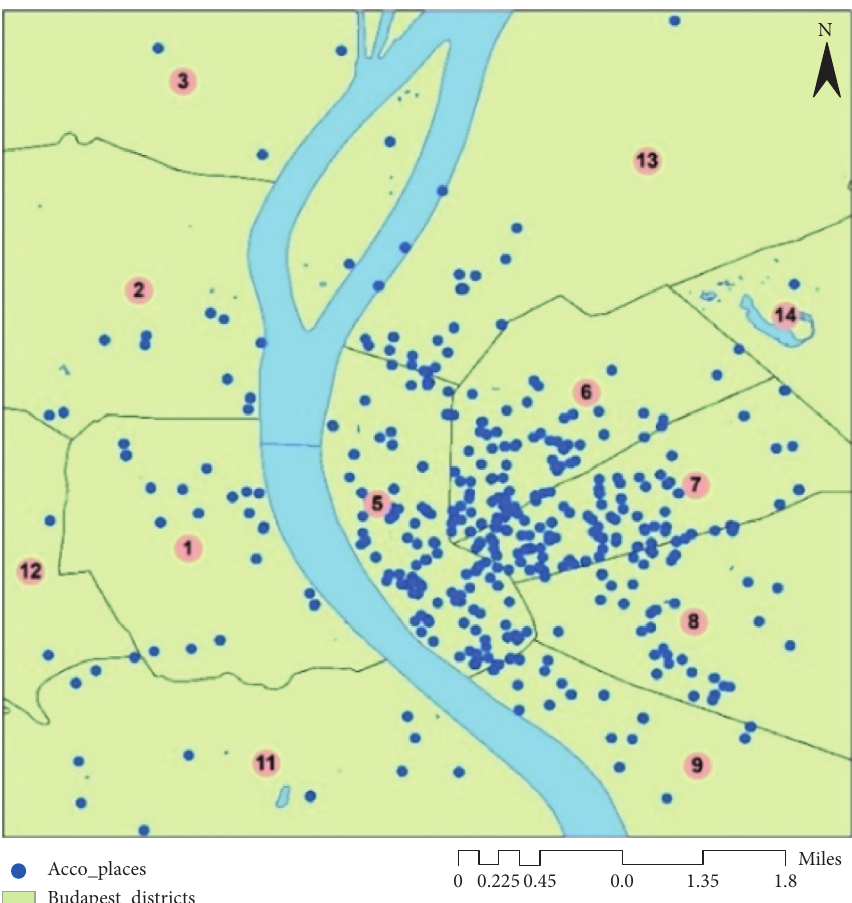
Figure 5: Places of accommodation in the study area.